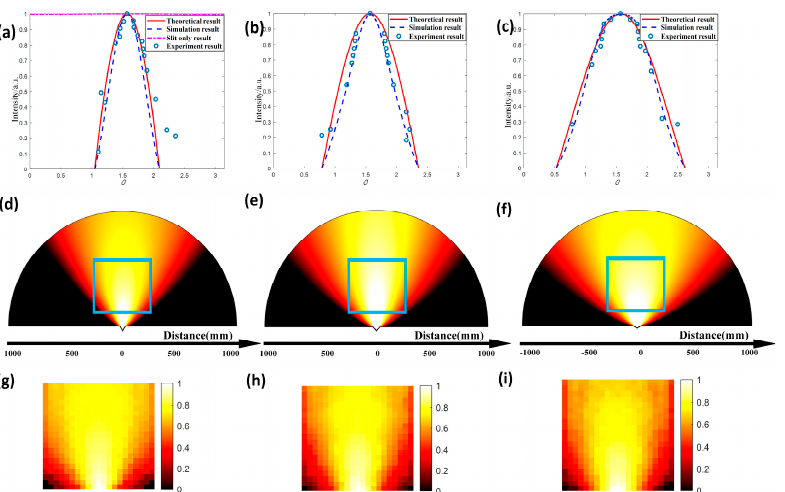
Figure 2. Simulation and experimental verification of directional radiation. Theoretical, simulated, and experimental normalized directivity diagram for | Z s / ρ 0 c 0 |≈ 0 and ( a ) α = 30 ◦ , ( b ) α = 45 ◦ , and ( c ) α = 60 ◦ ; the pink line in ( a ) is the simulation result for the structure with only one slit. Simulated sound pressure map for | Z s / ρ 0 c 0 |≈ 0 and ( d ) α = 30 ◦ , ( e ) α = 45 ◦ , and ( f ) α = 60 ◦ . Experimental sound pressure map for | Z s / ρ 0 c 0 | ≈ 0 and ( g ) α = 30 ◦ , ( h ) α = 45 ◦ , and ( i ) α = 60 ◦